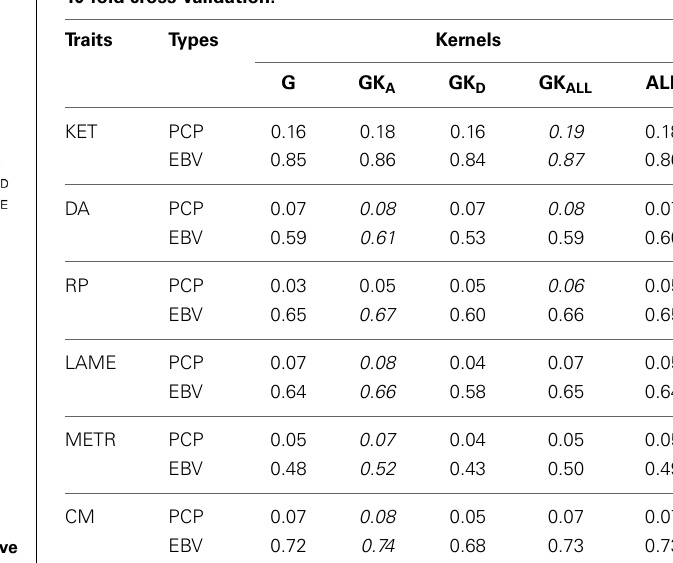
Table 2 | Predictive correlation for ketosis (KET), displaced abomasum (DA), retained placenta (RP), lameness (LAME), metritis (METR), and clinical mastitis (CM) using various kernels and the average of five 10-fold